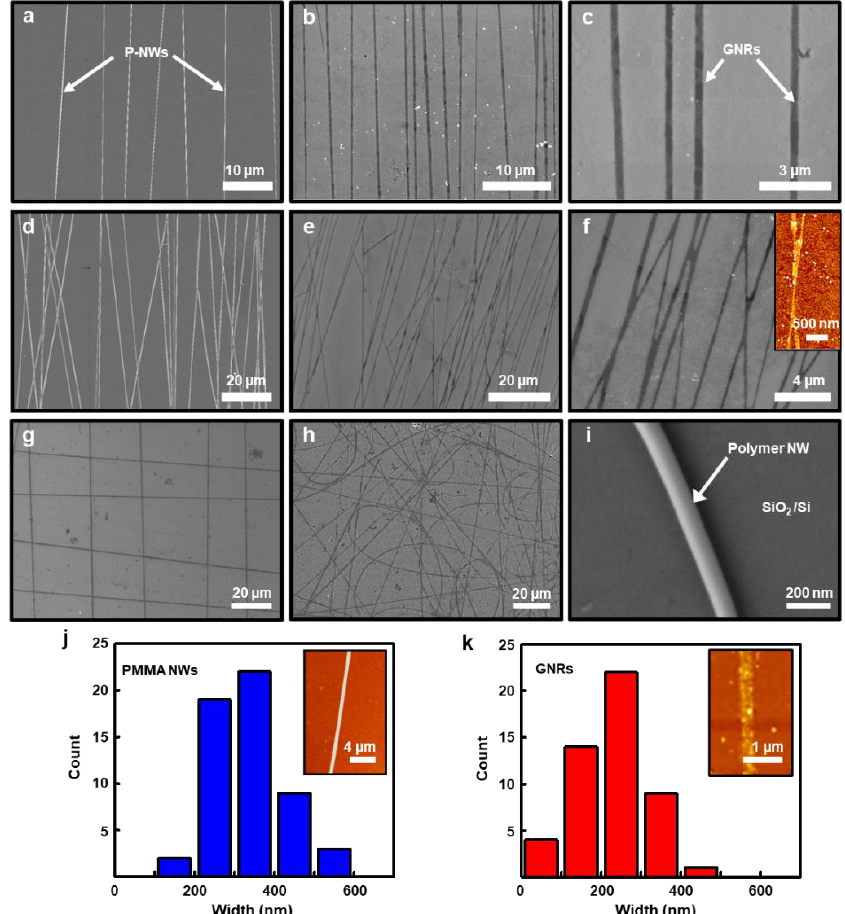
Figure 2. ( a ) SEM image of the aligned array of the electrospun p-NWs on a graphene sheet. ( b , c ) SEM images of the aligned array of GNRs after O 2 plasma and the removal of p-NWs. ( d ) SEM image of the aligned-network arrays of the electrospun p-NWs on a graphene sheet. ( e , f ) SEM images of the GNR-networks; the inset shows an AFM image of the Y-shaped GNR. ( g ) SEM image of the orthogonal crossed GNRs. ( h ) SEM image of the random networks of GNRs. ( i ) the electrospun p-NW on SiO 2 /Si substrate. ( j , k ) Histograms of measured widths from the p-NWs (i.e., etch-mask) and processed GNRs, respectively; the insets show representative AFM height images.